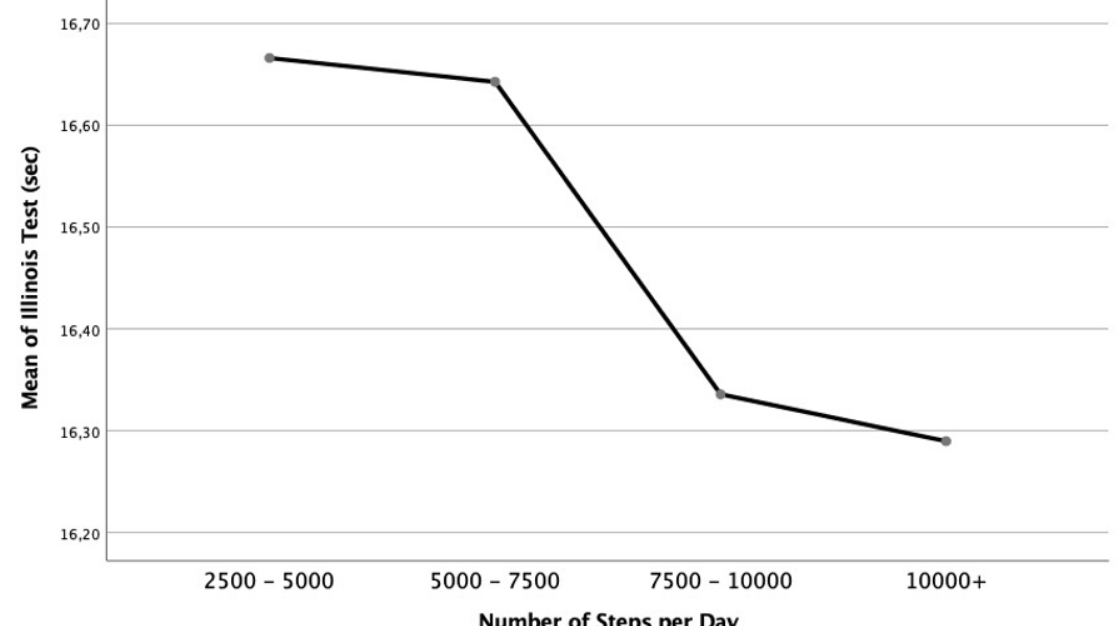
Figure 3. Average Illinois Agility Test (sec) according to the answers given by the participants to the number of steps per